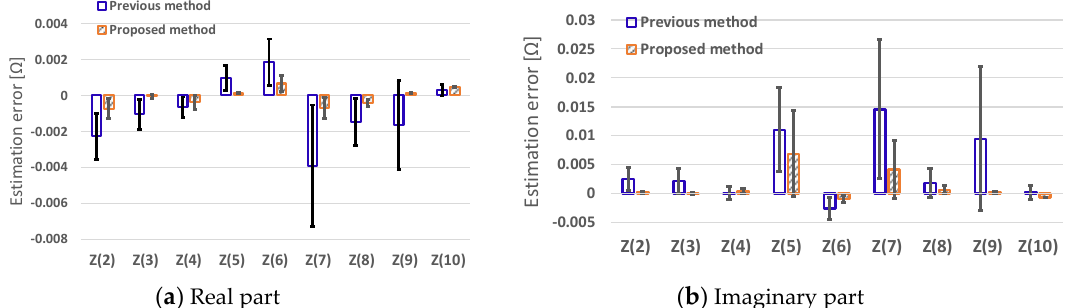
Figure 3. Average and 95% confidence interval for estimated impedance (real and imaginary part).